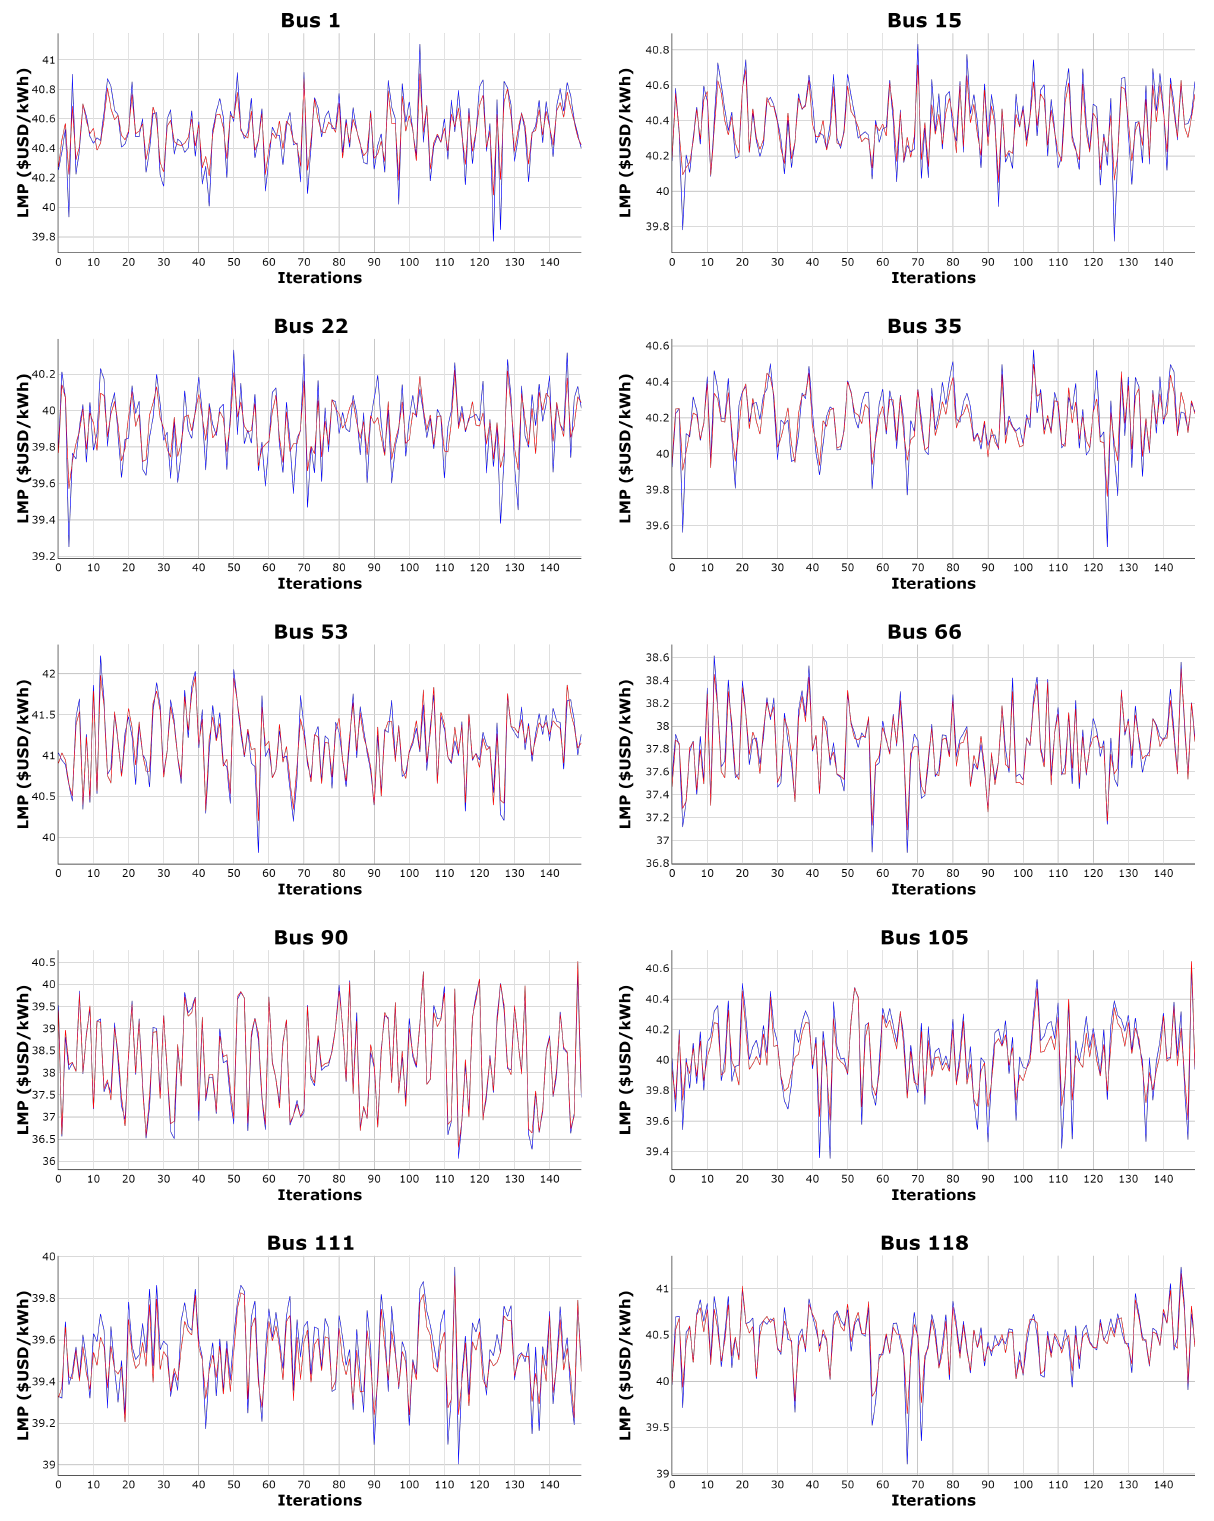
Figure 9. Comparison of predicted (red) and actual (blue) LMP values for some specific